Question: In one sentence, what is this figure communicating?
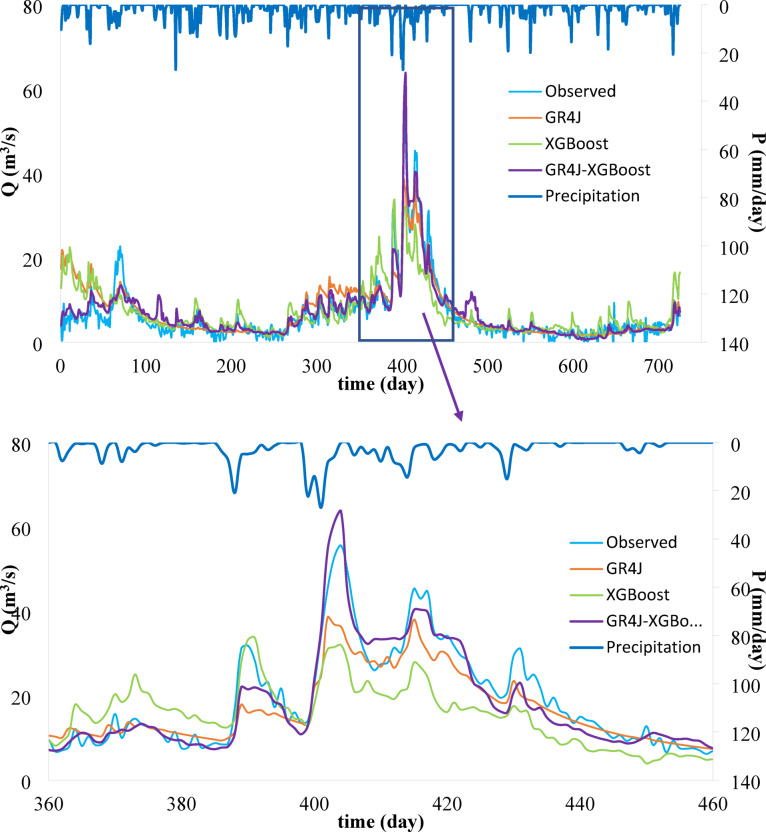
Answer: Time variation of observed and predicted streamflow: comparison of conceptual (GR4J), data-driven (XGBoost), and hybrid GR4J–XGBoost models for prediction during the testing period.